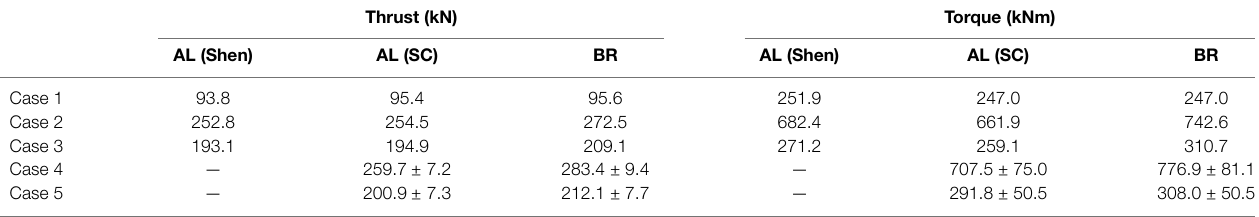
TABLE 2 | Total thrust and torque comparisons for all validation cases. For Case 4 and Case 5 (with turbulent inflow), the mean ± standard deviation is provided. Thrust